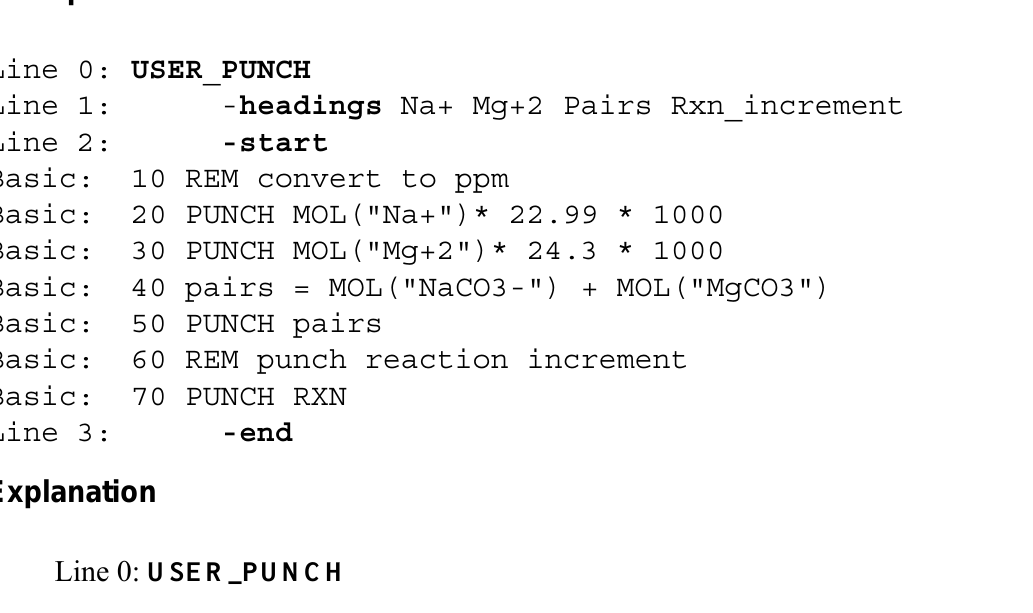
-headings —Headings will appear on the first line of the selected-output file. Optionally, heading , headings , or -h [ eadings ]. list of column headings —White-space-delimited (any combination of spaces and tabs) list of column